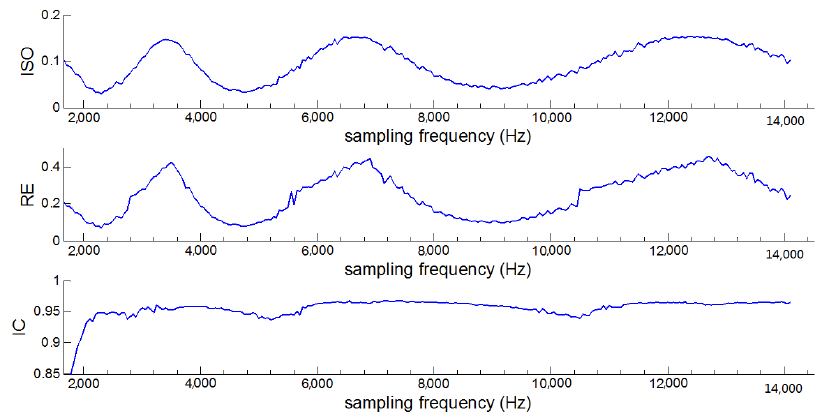
Figure 2. The effect of sampling on ensemble empirical mode decomposition (EEMD) performance. ISO, successive IMF orthogonality; RE, residual energy; IC, IMF coherence. The decomposition results of the simulated signal with different sampling frequencies of 9450 Hz and 12,100 Hz are illustrated in Figure 3.